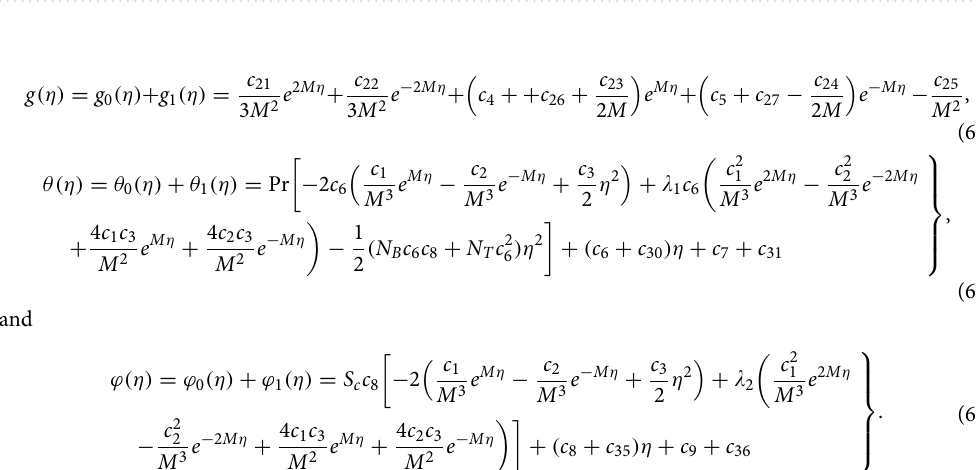
Figure 2. Variation of the radial velocity f ′ (η) versus η as given in Eq. (64) to illustrate the impact of the material factor K